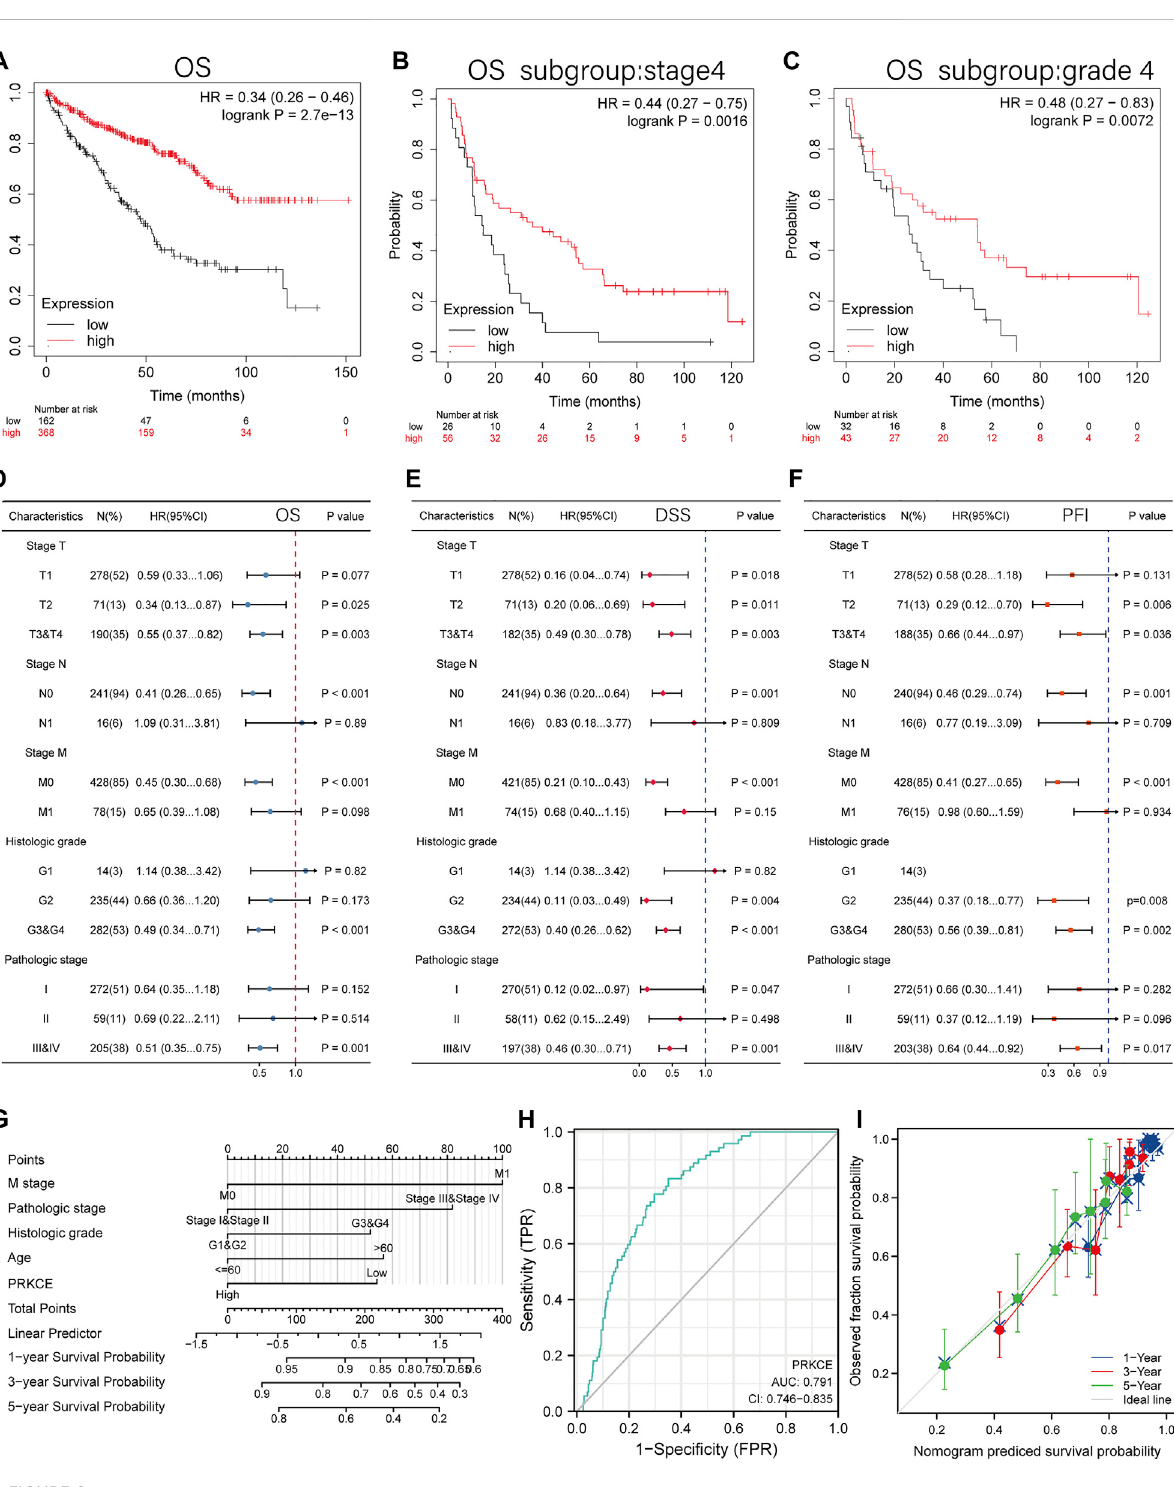
FIGURE 2 The prognosis value of the PRKCE expression in KIRC. (A) Kaplan-Meier overall survival (OS) curves comparing the low and high expression of PRKCE in KIRC in Kaplan-Meier Plotter. (B – C) OS Survival curves of stage4 and grade4 subgroups comparing the low and high expression of PRKCE in KIRC in Kaplan-Meier Plotter. (D – F) Forest plots displaying clinical subgroup analyses of KIRC prognosis (OS, DSS, and PFI) in the TCGA database. (G) A nomogram that integrates PRKCE and other prognosis factors in KIRC from TCGA data. (H) Receiver operating characteristic (ROC) curve for PRKCE expression in KIRC. (I) Calibration plots of the nomogram for estimating the probability of OS at 1, 3, and 5